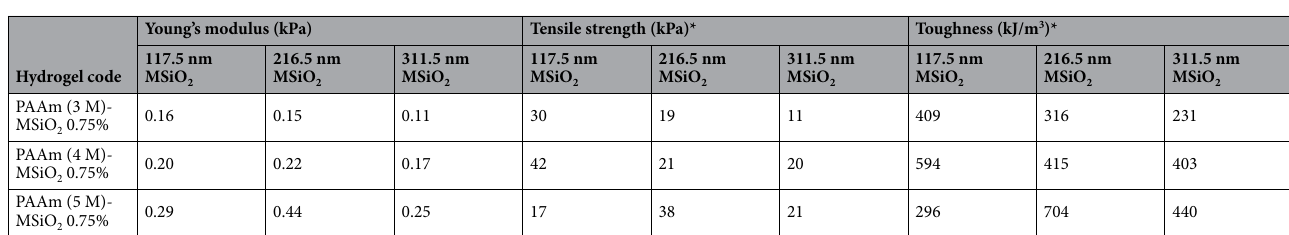
Table 3. Summary of tensile properties of PAAm-MSiO 2 hydrogels prepared by varying concentrations of AAm (3 M, 4 M, and 5 M) and keeping the constant concentration (0.75 wt%) of MSiO 2 particles